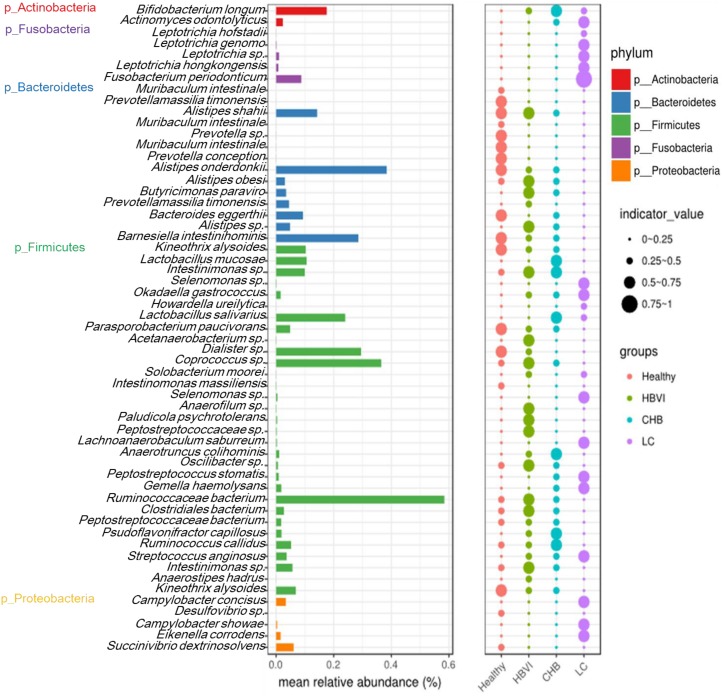
Indicator species significantly (q < 0.1) associated with the disease progression. The bar indicates the relative abundance of each indicator species, while the size of each circle represents the indicator value (association strength) of a specific species with the different group: 0–0.25, not characteristic; 0.25–0.5, weakly characteristic; 0.5–0.75, characteristic; and 0.75–1.0, strongly characteristic. The color scheme for Healthy, HBVI, CHB and LC in the graph are red, green, blue, and purple.